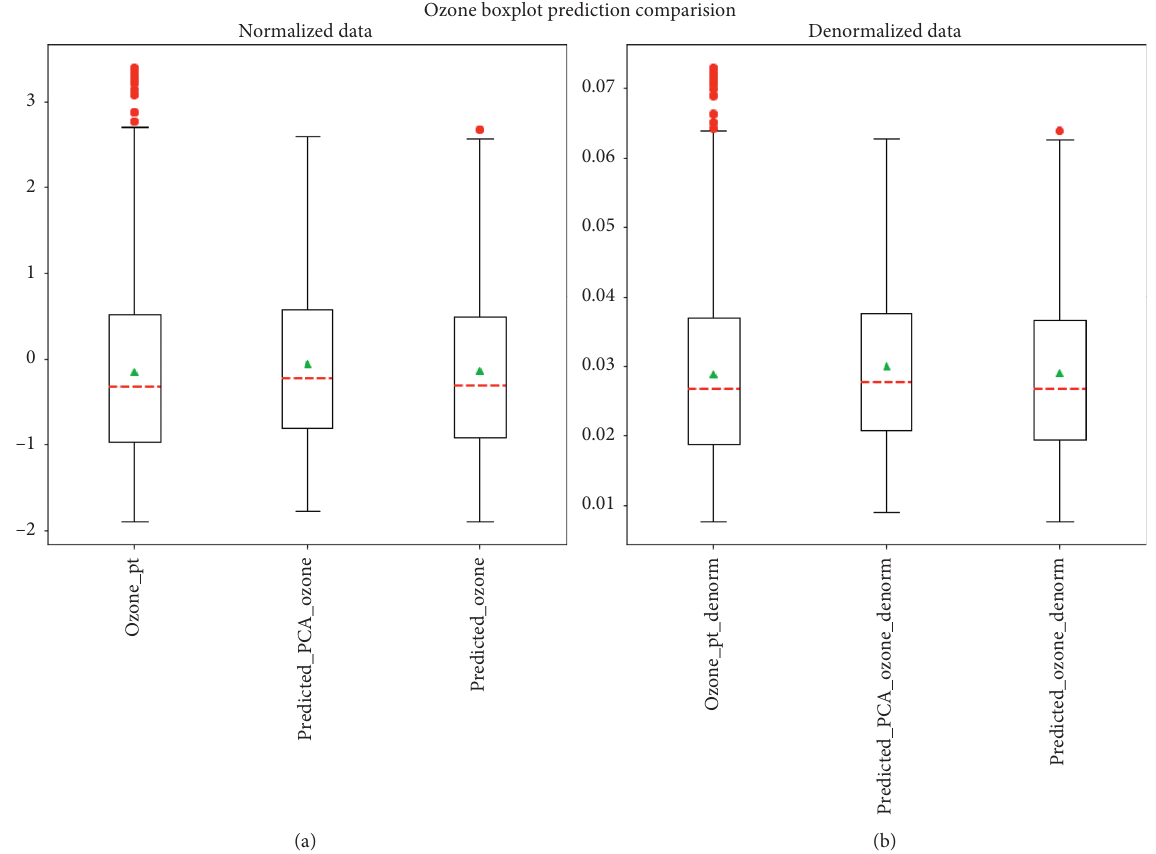
Figure 14: Boxplot representation of observed and forecasted ground-level ozone values (PCA and normalized dataset, before and after Yeo-Johnson power Table 9: Forecasting models’ error metrics for ozone measurement in the training and validation sets. Error metrics